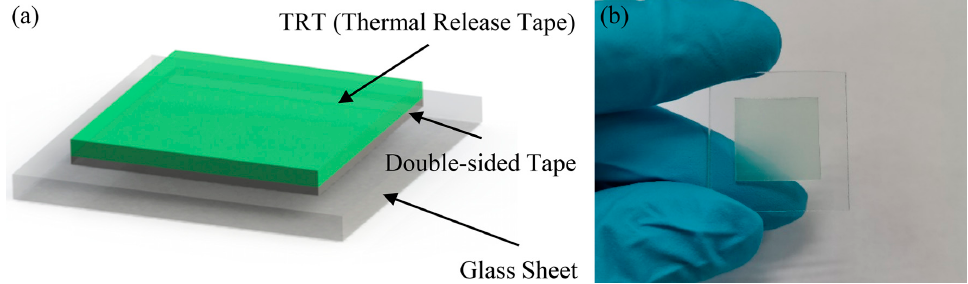
Figure 6. The schematic diagram ( a ) and the optical image ( b ) of the temporary carrier.